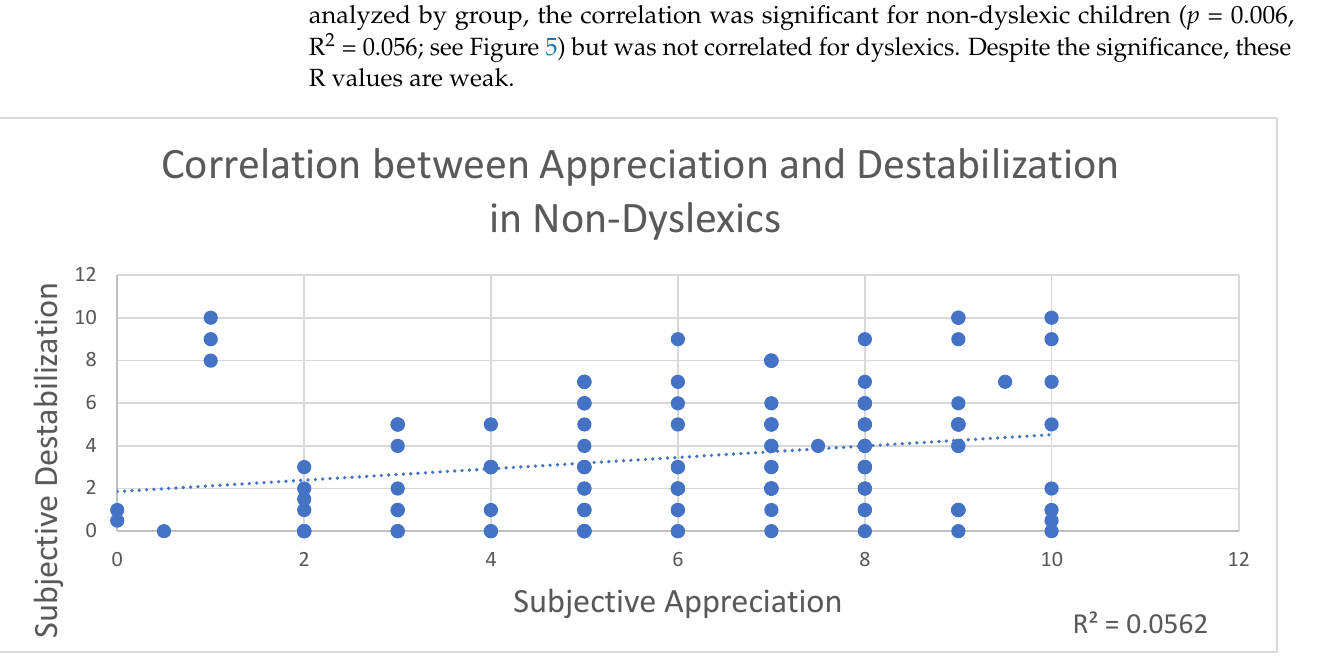
Figure 5. Correlation between appreciation and destabilization for all paintings in non-dyslexics.